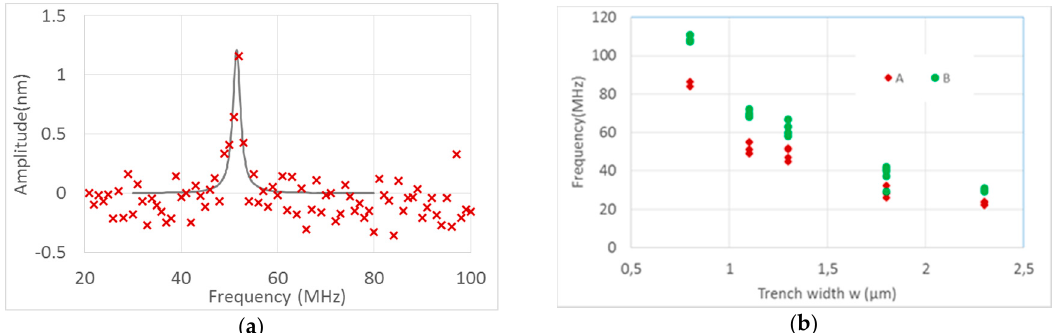
Figure 3. Natural resonance observation and measurement at low excitation level. AFM is used to measure the envelope of vibration of the membrane. ( a ) frequency spectrum taken on a 1.3 μ m wide sample device, with V dc = 4 V, v ac = 0.5 V. The resonant frequency appears to be f 0 = 52 MHz; ( b ) resonance frequencies related to trench width for the two sets of devices differing by the thickness of amorphous carbon. Resonance frequencies range from 20 Hz for the 2.3 μ m wide trenches to 110 MHz for the 0.8 μ m wide